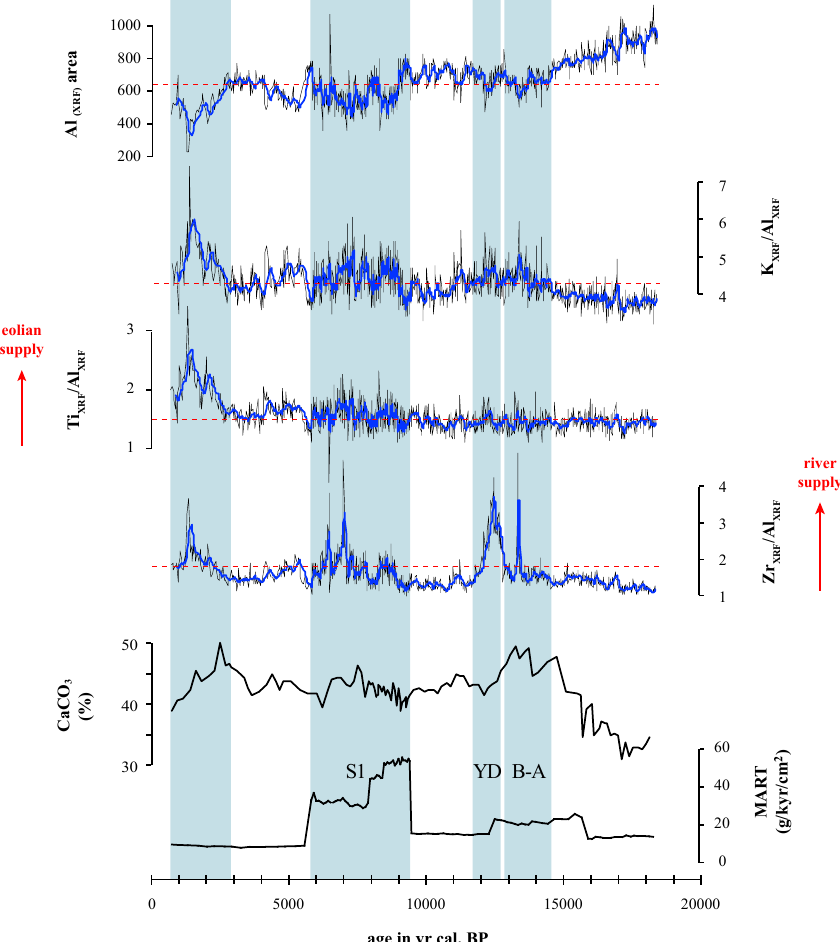
Fig. 4. Geochemical data for core MD04-2797, Al XRF content (counts/s), Ti XRF / Al XRF ratio, Zr XRF / Al XRF ratio (counts/s), CaCO 3 (%) and MART (gkyr − 1 cm − 2 ) from Fig.